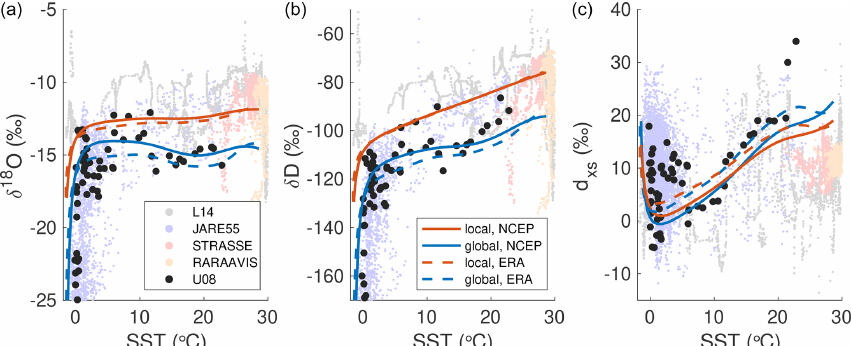
Figure A2. Modeled isotopic values of evaporation compared to Southern Ocean vapor measurements. (a) Modeled δ 18 O versus SST using the “local” closure assumption (red lines) and “global” closure assumption (blue lines). We use two different reanalysis datasets for the SST and RH climatology: NCEP/NCAR (solid lines) and ERA-Interim (dashed lines). Black dots are discrete vapor measurements from the Southern Ocean made by Uemura et al. (2008) (U08), while grey, blue, red, and yellow dots are continuous ship-based Southern Ocean vapor measurements made by Liu et al. (2014) (L14), Kurita et al. (2016) (JARE55), and Benetti et al. (2017) (STRASSE, RARA AVIS), respectively. (b) Same as (a) but for modeled δ D versus SST. (c) Same as (a) but for modeled d xs versus SST. The vertical tails at low SST in panels (a) and (b) result from SSTs asymptoting to the freezing point of seawater while air temperatures may continue to decrease.